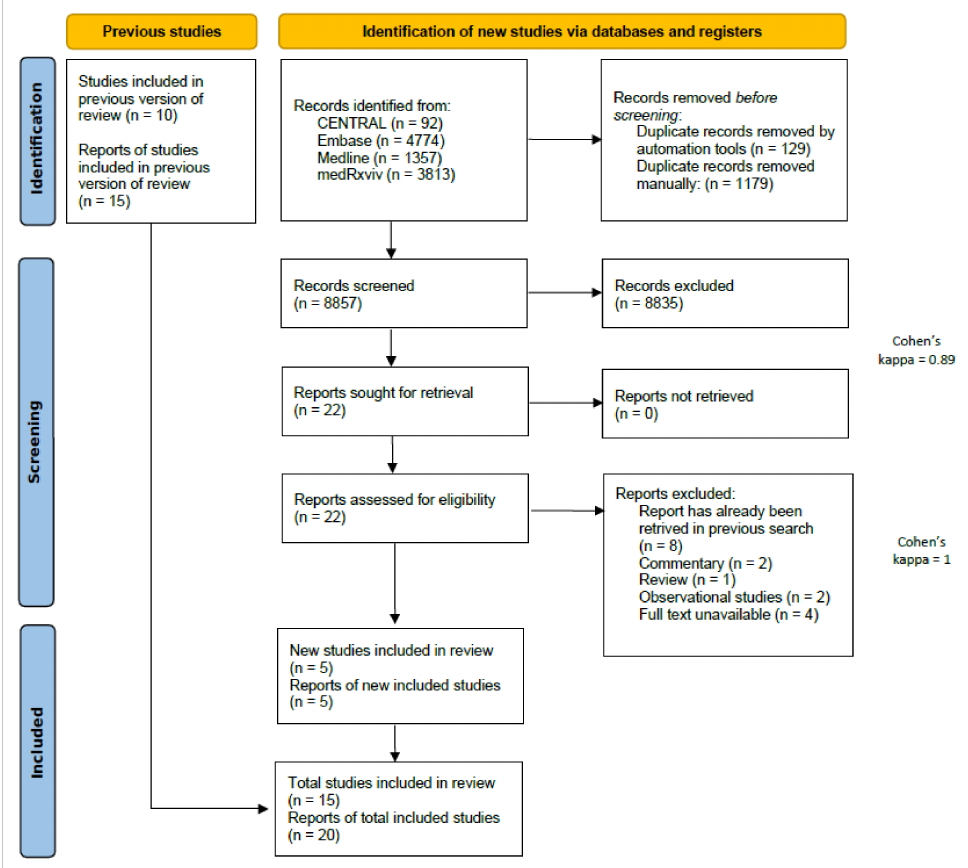
Figure 1. PRISMA 2020 flow diagram of the updated